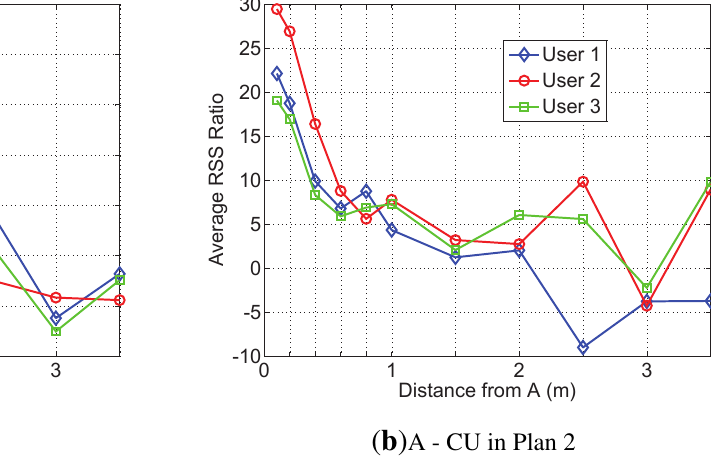
Figure 8. The average RSS ratio of CU-A in Plan 1 and A-CU in Plan